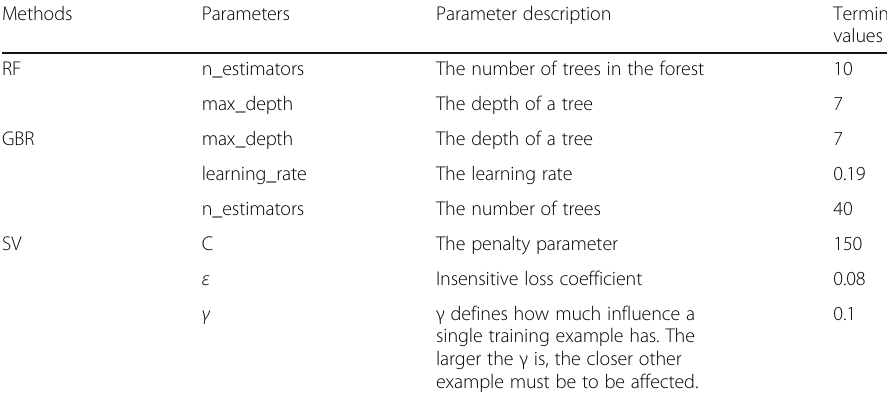
Table 4 Optimized parameters of RF, GBR, and SVR Methods